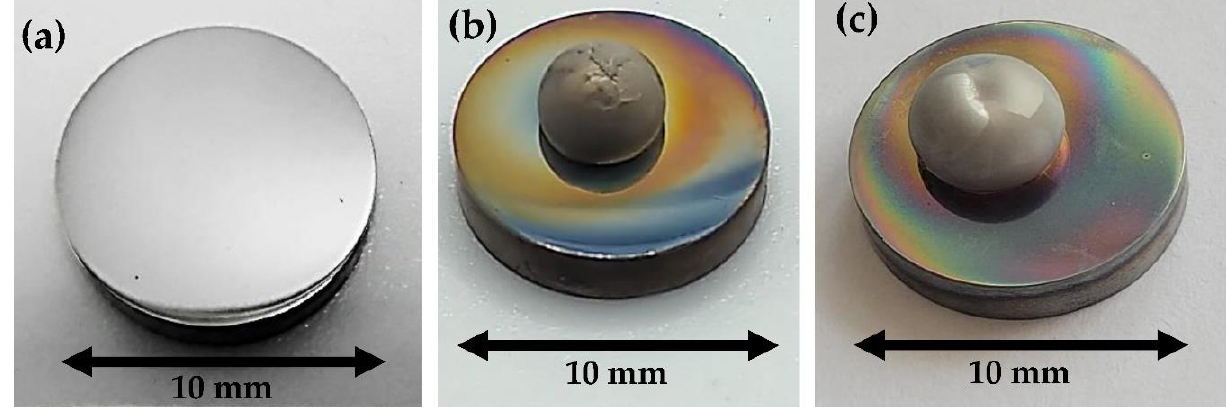
Figure 2. Side-view photos of tungsten substrates before ( a ) and after ( b , c ) the wettability experiments in the Ar ( b ) and in the Ar + 5 wt.% H 2 ( c ) atmosphere.